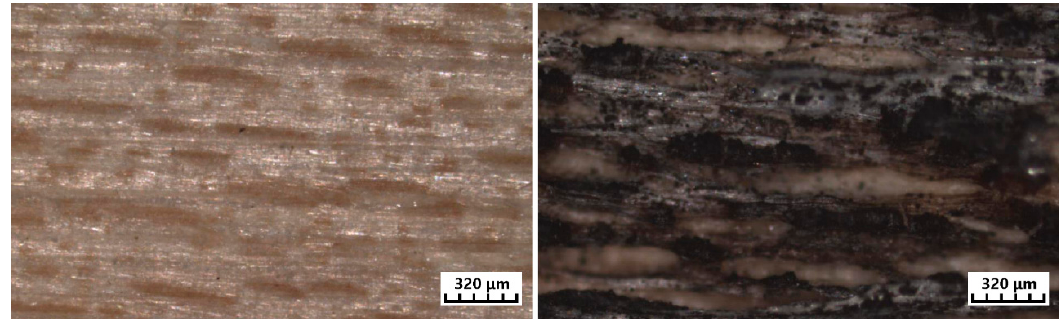
Figure 12. Confocal laser scanning microscopy of maple wood before and after 2 years of weathering (detail).